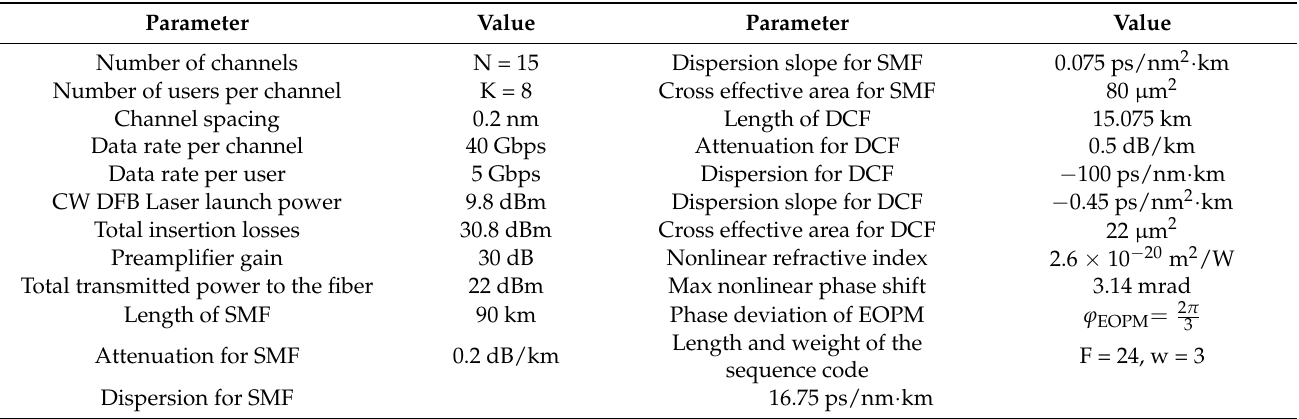
Table 1. Hybrid System